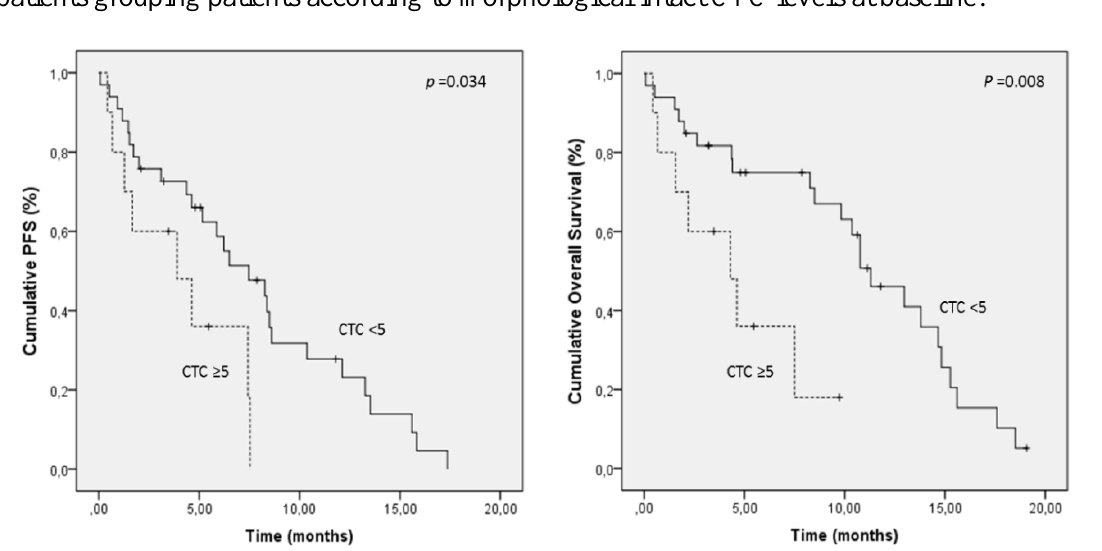
Figure 2. Kaplan-Meier curves for progression-free survival and overall survival of NSCLC patients grouping patients according to morphological intact CTC levels at